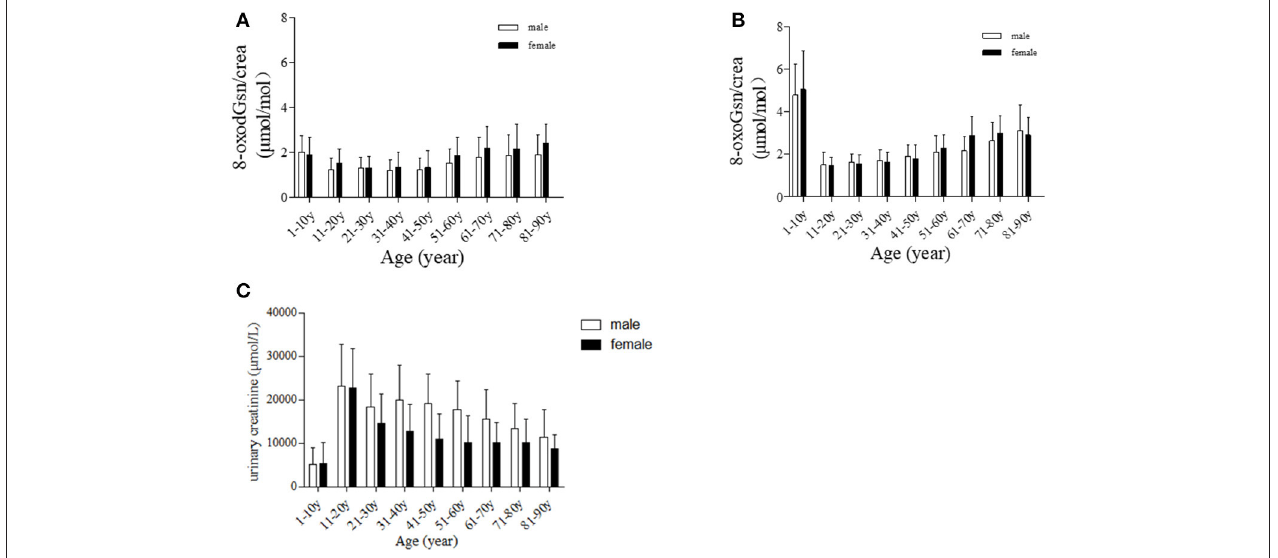
FIGURE 2 | Age-dependent changes in urinary oxidized guanosine and creatinine. (A) Age-dependent changes in 8-oxodGsn. (B) Age-dependent changes in 8-oxoGsn. (C) Age-dependent changes in urinary creatinine.